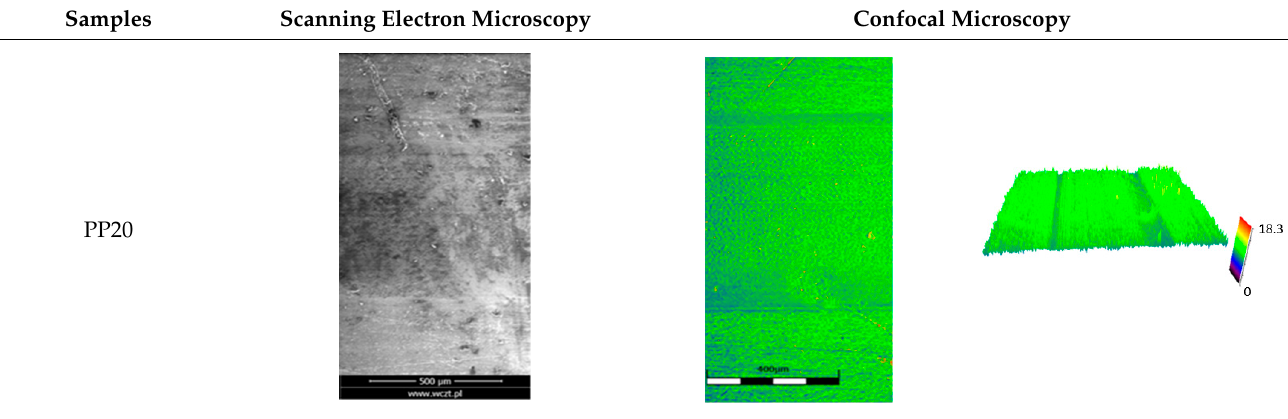
Table 4. Comparison of friction area observed by Scanning Electron Microscopy and confocal microscopy. Samples